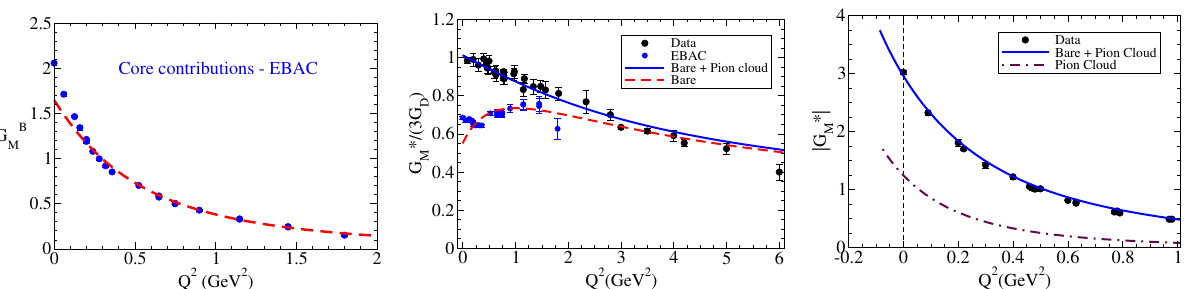
Figure 1. γ ∗ N → Δ (1232) magnetic form factor. Left: Comparison of bare contribution with EBAC estimate from [31]. Center: Form factor normalized by 3 G D , where G D = (1 + Q 2 / Λ 2 D ) − 2 , with Λ 2 D = 0 . 71 GeV 2 . Right: Re-parametrization of | G ∗ M | based on expression (2) for the pion cloud with Λ 2 D = 0 . 9 GeV 2 [28]. Extension to the timelike region. Database from [10,